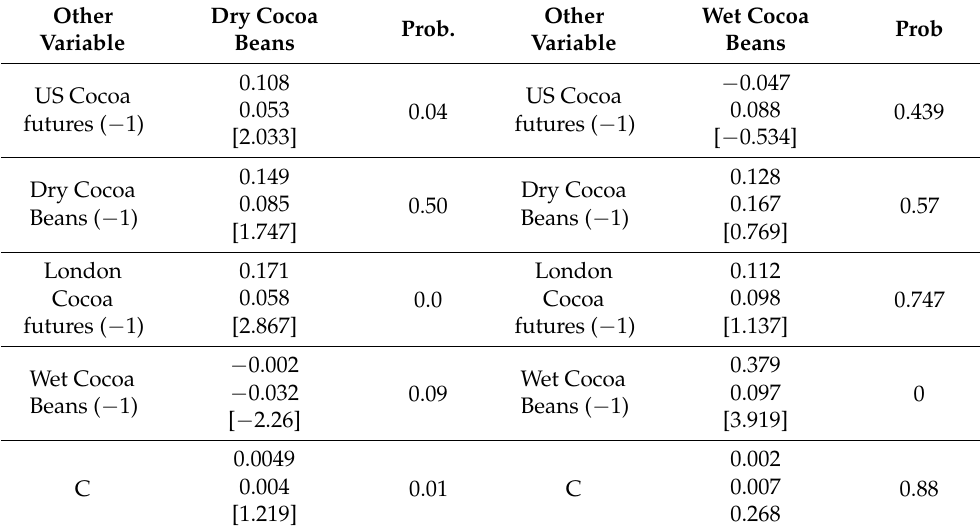
Table 9. VAR (1) regression